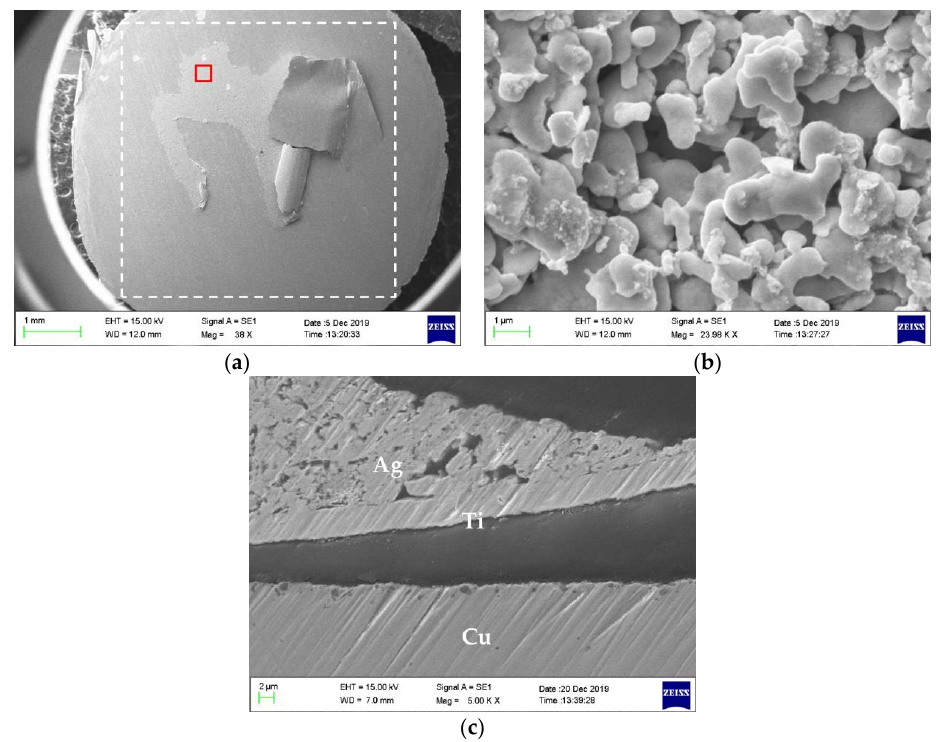
Figure 4. SEM images of the fracture of a micron silver joint after shear testing. The white frame represents the die position: ( a ) fracture occurs at the substrate–joint interface; ( b ) larger view of micron silver particles coalescing from selected red region in ( a ); ( c ) the metallized layer is separated from the